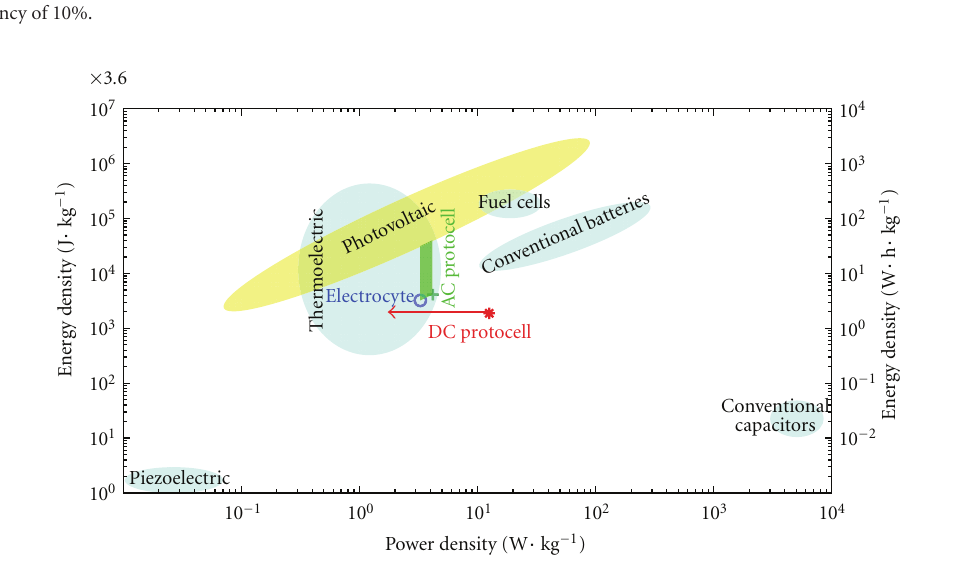
Figure 3: Ragone chart comparing the natural electrocyte, AC protocells, and DC protocells with conventional batteries, capacitors, and other energy conversion devices, including piezoelectric, thermoelectric, and photovoltaic devices (data for these other devices from [28, 85, 86, 88–90]). The AC protocell performance is described by a parallelogram; the bottom edge indicates the performance of AC protocells from initial design parameters (i.e., the natural electrocyte, marked with “ (cid:4) ”) to the optimal design parameters (marked with “+”) at 1 h continuous output; the top edge indicates the performance of AC protocells at 10 h continuous output; the left and right sides reflect the performance of AC protocells spanning from 1h to 10